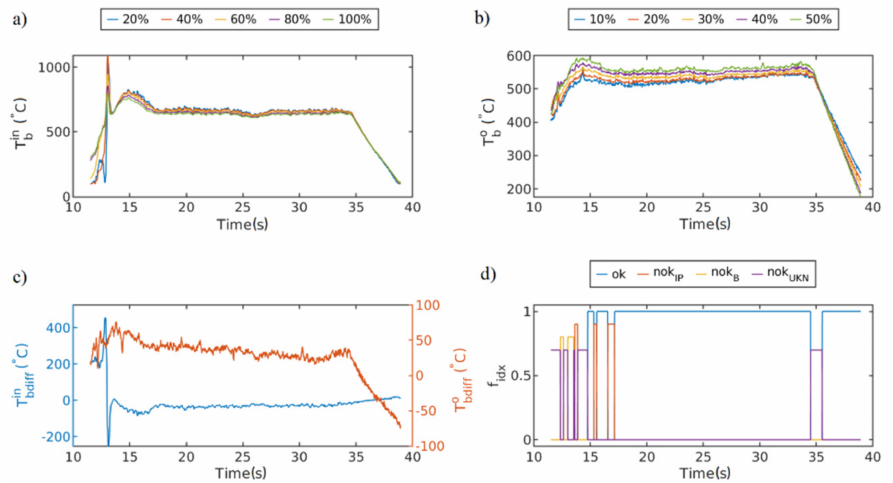
Figure 16. Feature and detection result for S13 using the original IR sequence: ( a ) inner band temperature distribution T in , ( b ) outer band temperature distribution T in b and T o , ( d ) weld defect detection result. bdif f